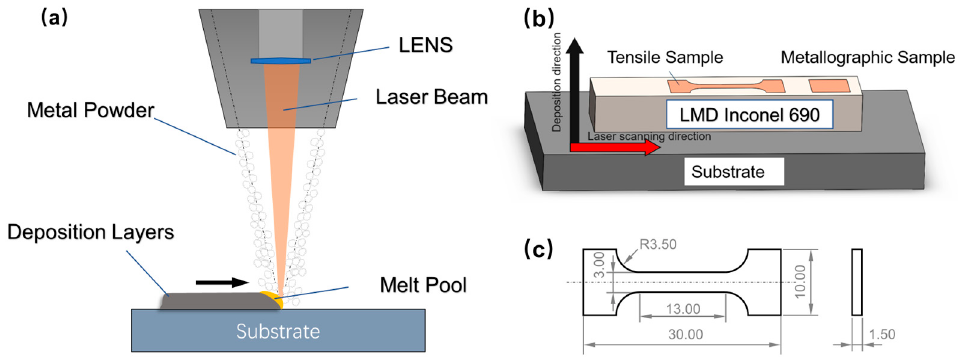
Figure 1. SEM morphology of Inconel 690 powder for LMD, with the upper inset showing microdendritic microstructure.